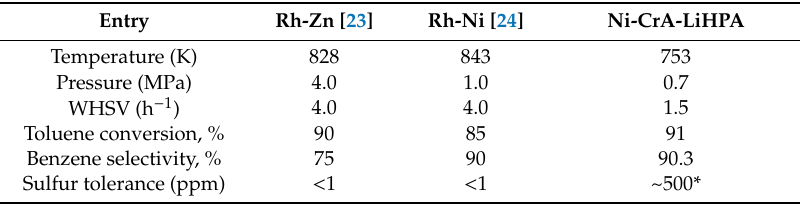
Table 4. Toluene Hydrodealkylation over alumina supported